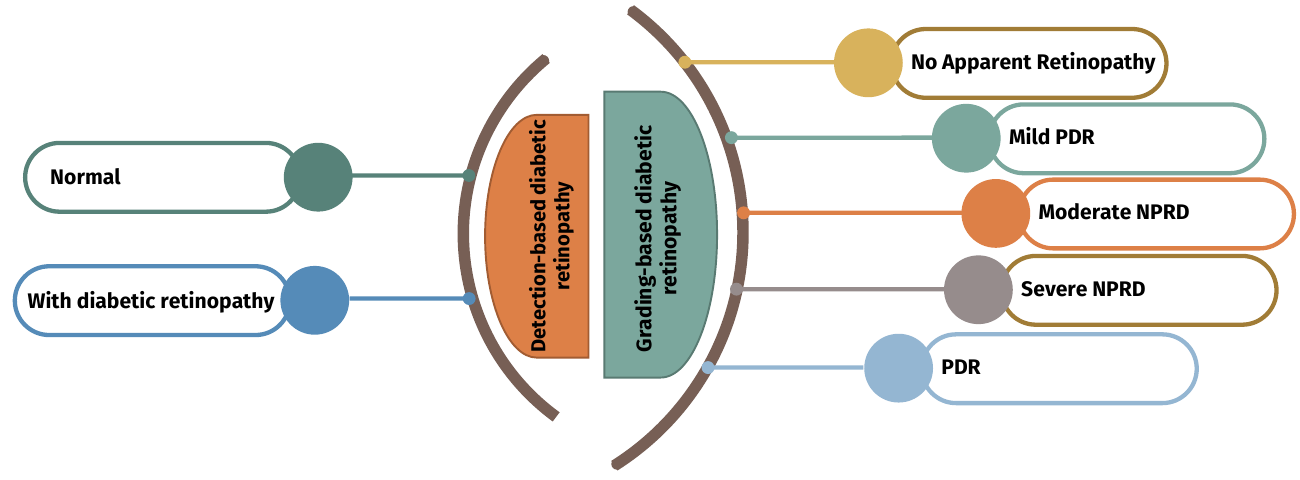
Figure 2. Types of diabetic retinopathy